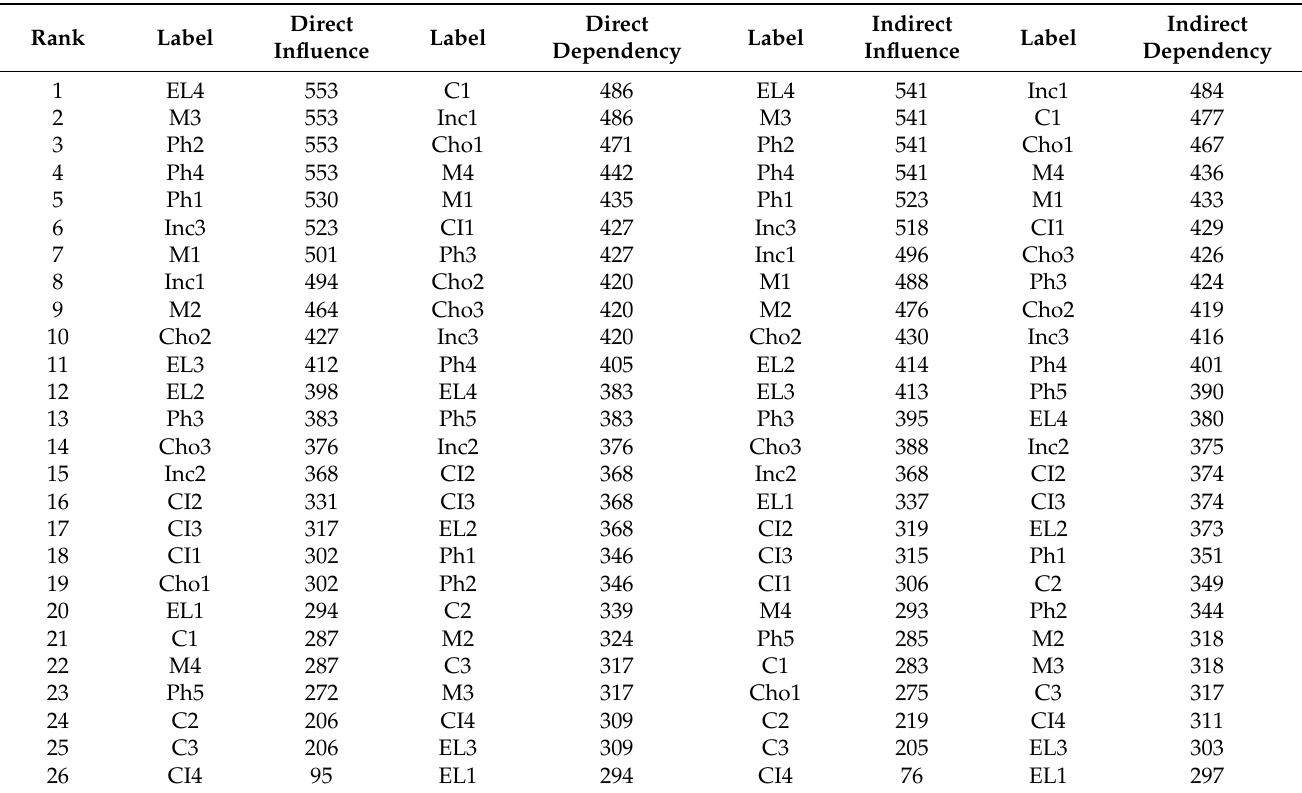
Table 2. Numerical weights of the studied risk